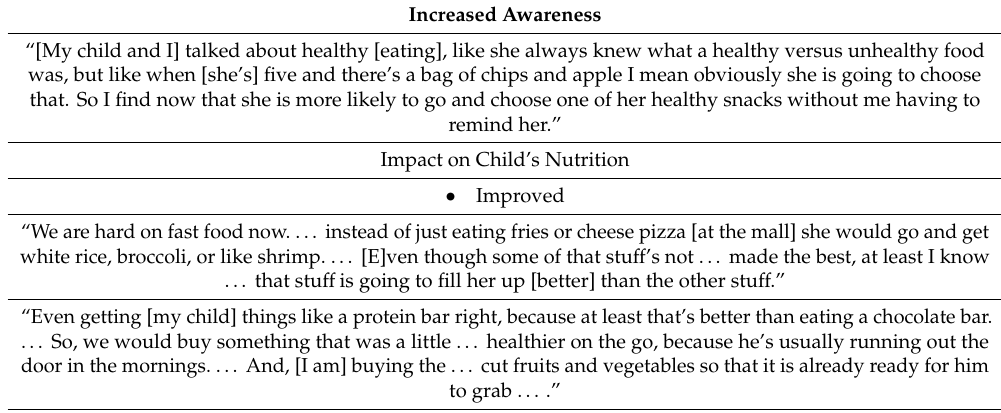
Table 10. Corroborative Quotations for Post-Intervention Themes and Sub-Themes (Control